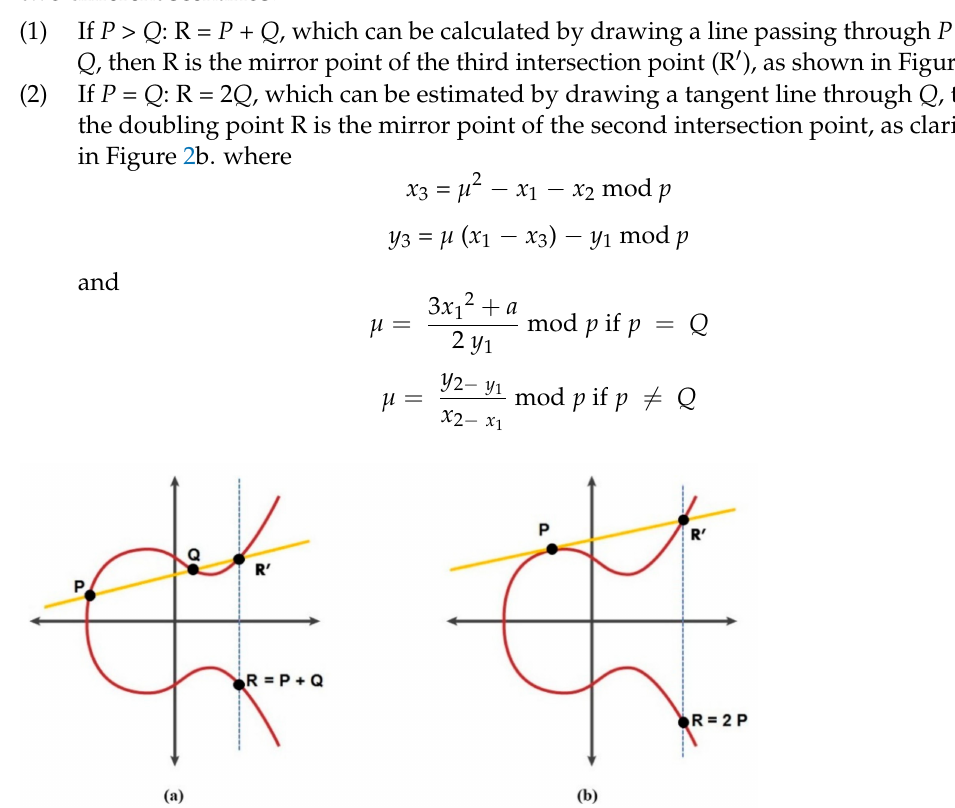
Figure 2. Demonstration of elliptic curve mathematical operations: ( a ) point summation and ( b ) point doubling.